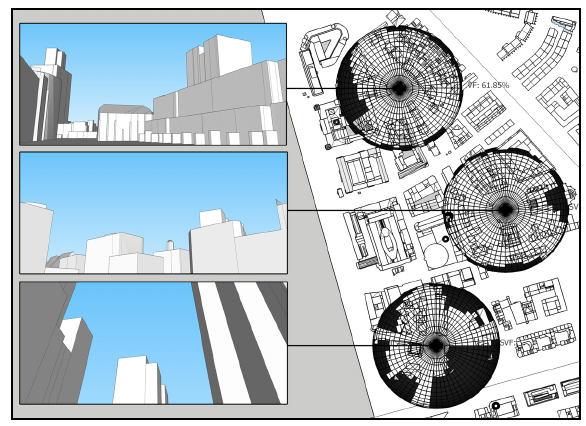
Figure 16. Relation between SVF and perception from user POV (point of view) – 3 locations within public spaces in centre of Rotterdam (cityGML – LOD2), by: